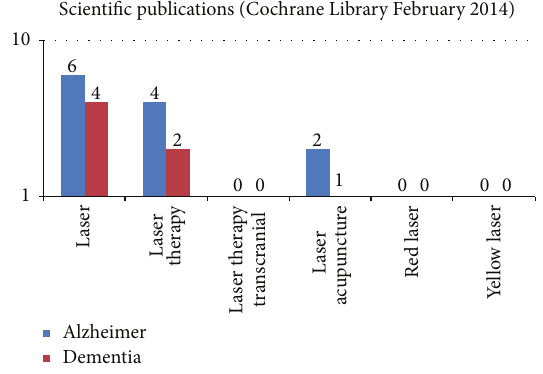
Figure 2: Scientific publications related to the topic in the scientific database Cochrane